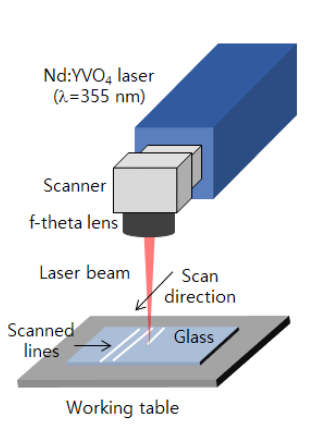
Figure 1. Schematic diagram of the laser grooving experiment.